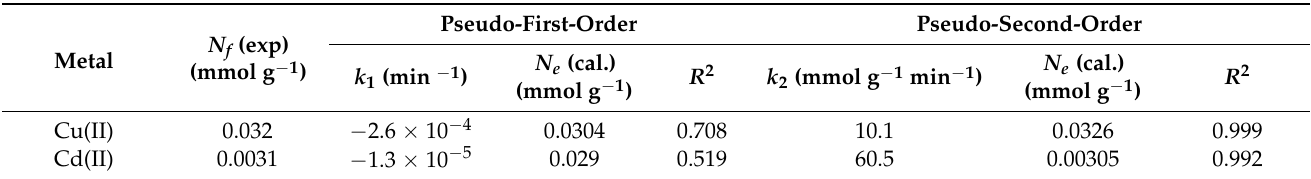
Table 2. Parameters for the pseudo-first- and pseudo-second-order kinetic models and their respective correlation coefficients for each metal ion. The experimental adsorption capacity of Si-Pu for the greatest contact time is also found for comparison.